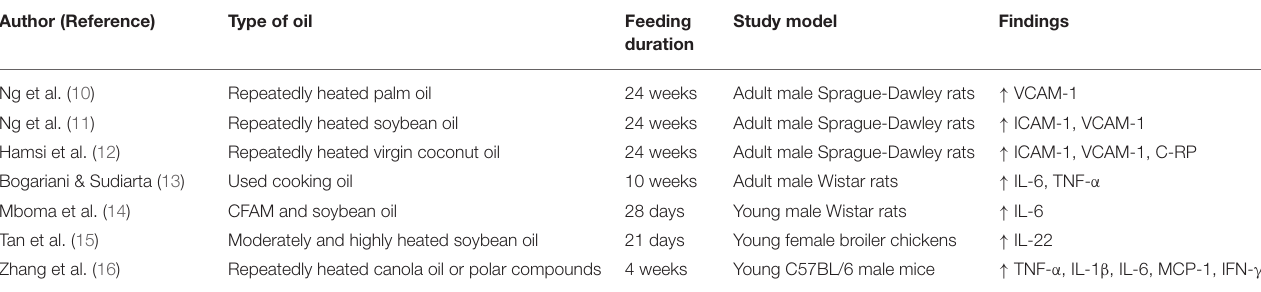
TABLE 1 | Effect of heated culinary oil on